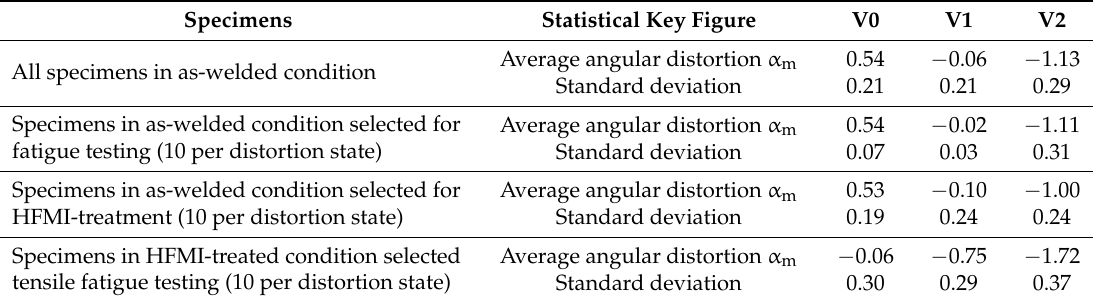
Figure 3. Distortion measurements over specimen position in array during welding. Table 1. Summary of angular distortion measurements in degrees.